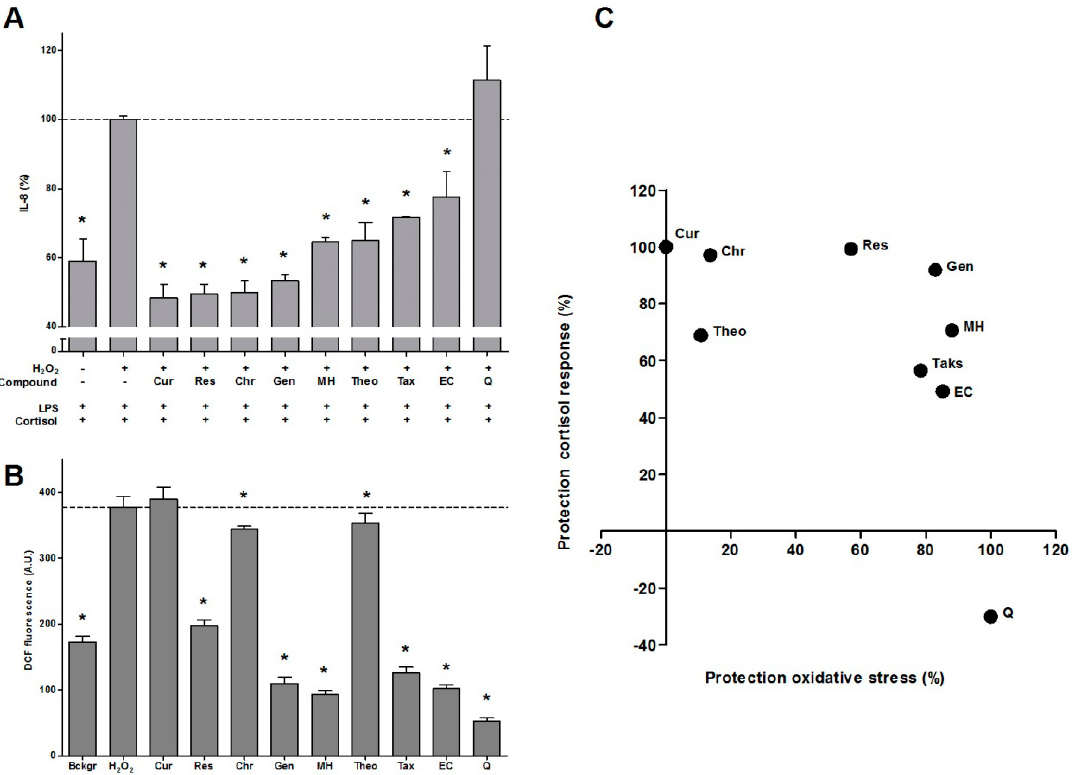
Figure 1. Effect of bioactives on intracellular oxidative stress and glucocorticoid resistance arranged in accordance to their ability to restore the anti-inflammatory effect of cortisol. ( A ) IL-8 levels (%) in medium after cells were pre-incubated with H 2 O 2 (800 µM) ± bioactives (10 µM) for 1 h. and subsequently exposed to LPS (10 ng/mL) and cortisol (100 nM) for 16 h ( N = 6, mean ± SEM); ( B ) Intracellular oxidative stress levels. Differentiated monocytes were incubated with DCFH for 45 min and then exposed to H 2 O 2 (800 µM) ± bioactives (10 µM) and fluorescence was recorded for 1 h ( N = 4, mean ± SD, * p < 0.05 Dunnett’s); ( C ) Correlation of the ability to reduce intracellular oxidative stress and to protect the cortisol response. Dotted lines represent maximal IL-8 production or fluorescence because no bioactives were added during H 2 O 2 incubation. Table 1. Antioxidant effect and protection of the cortisol response by bioactives (10 µM). Antioxidant Protection Cortisol Compound Abbr. Antioxidant Effect Compound Abbr. Effect (%)